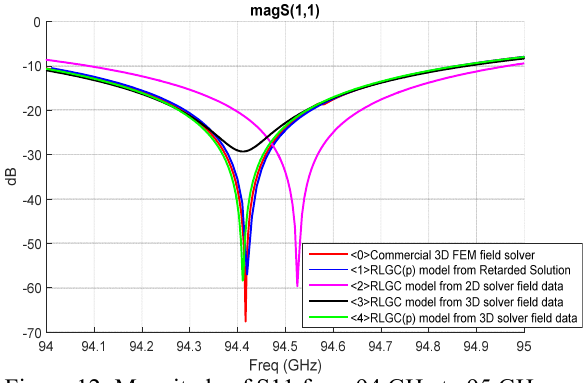
Figure 12: Magnitude of S11 from 94 GHz to 95 GHz